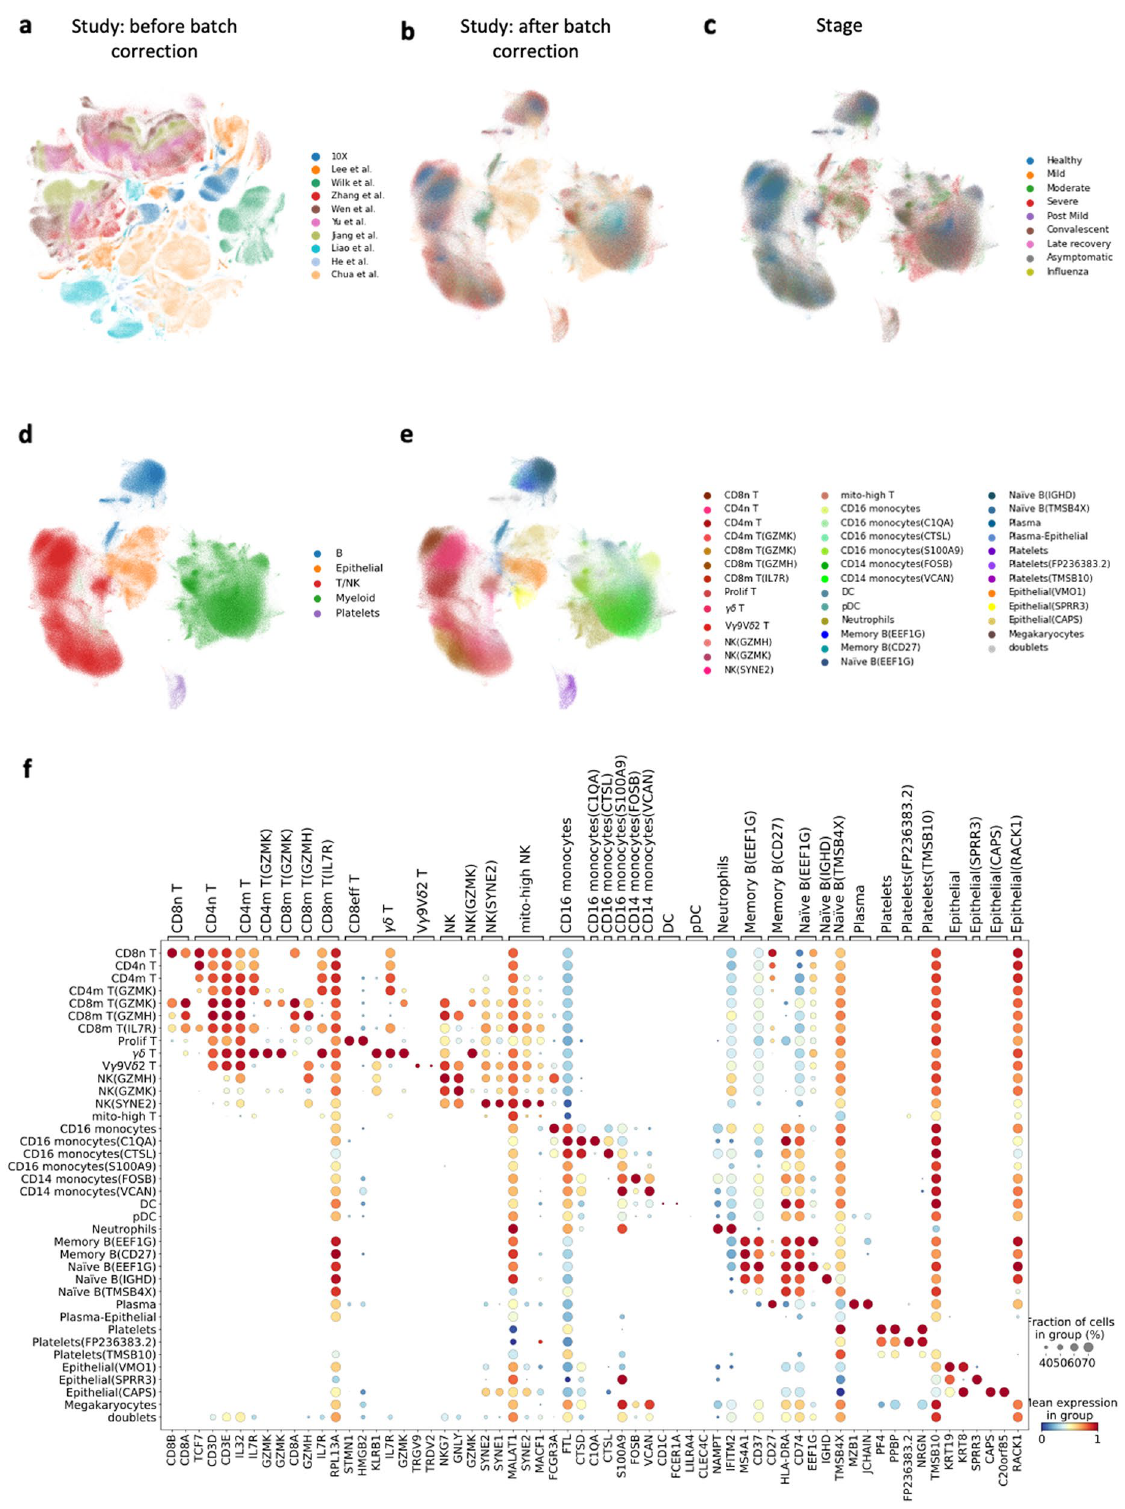
Figure 2. Meta-analysis identifies common and tissue-specific immune cell types. ( a ) The UMAP representation of the cells before batch correction, in which the cells are colored by study; ( b ) the UMAP representation of the cells after batch correction; ( c ) the UMAP representation colored by the disease stage when the sample were taken from the patients; ( d ) the UMAP colored by the main cell types; ( e ) the description of the cell populations in detail; ( f ) the marker genes for discriminating the cell